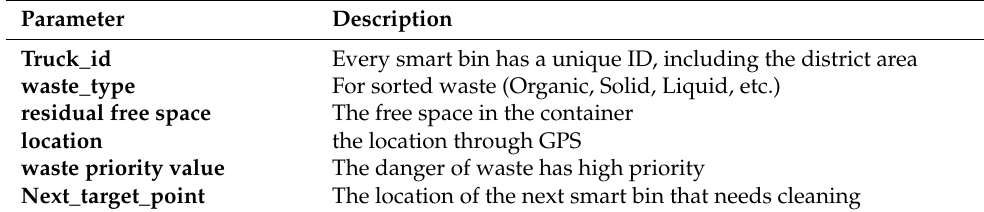
Table 3. Parameters of smart truck waste